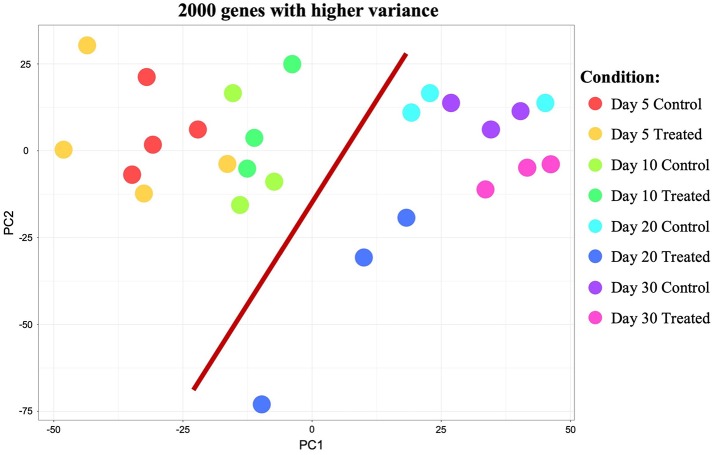
Principal component analysis (PCA) plot of all samples showing the 2,000 genes that presented higher variance. Distribution of samples appears to be mainly based on the effect of time (highlighted by red bar separating samples from days 5 and 10 from samples from days 20 and 30). Samples distribution and scattering also suggest stronger effects of treatment on day 20 than on the other time points studied.